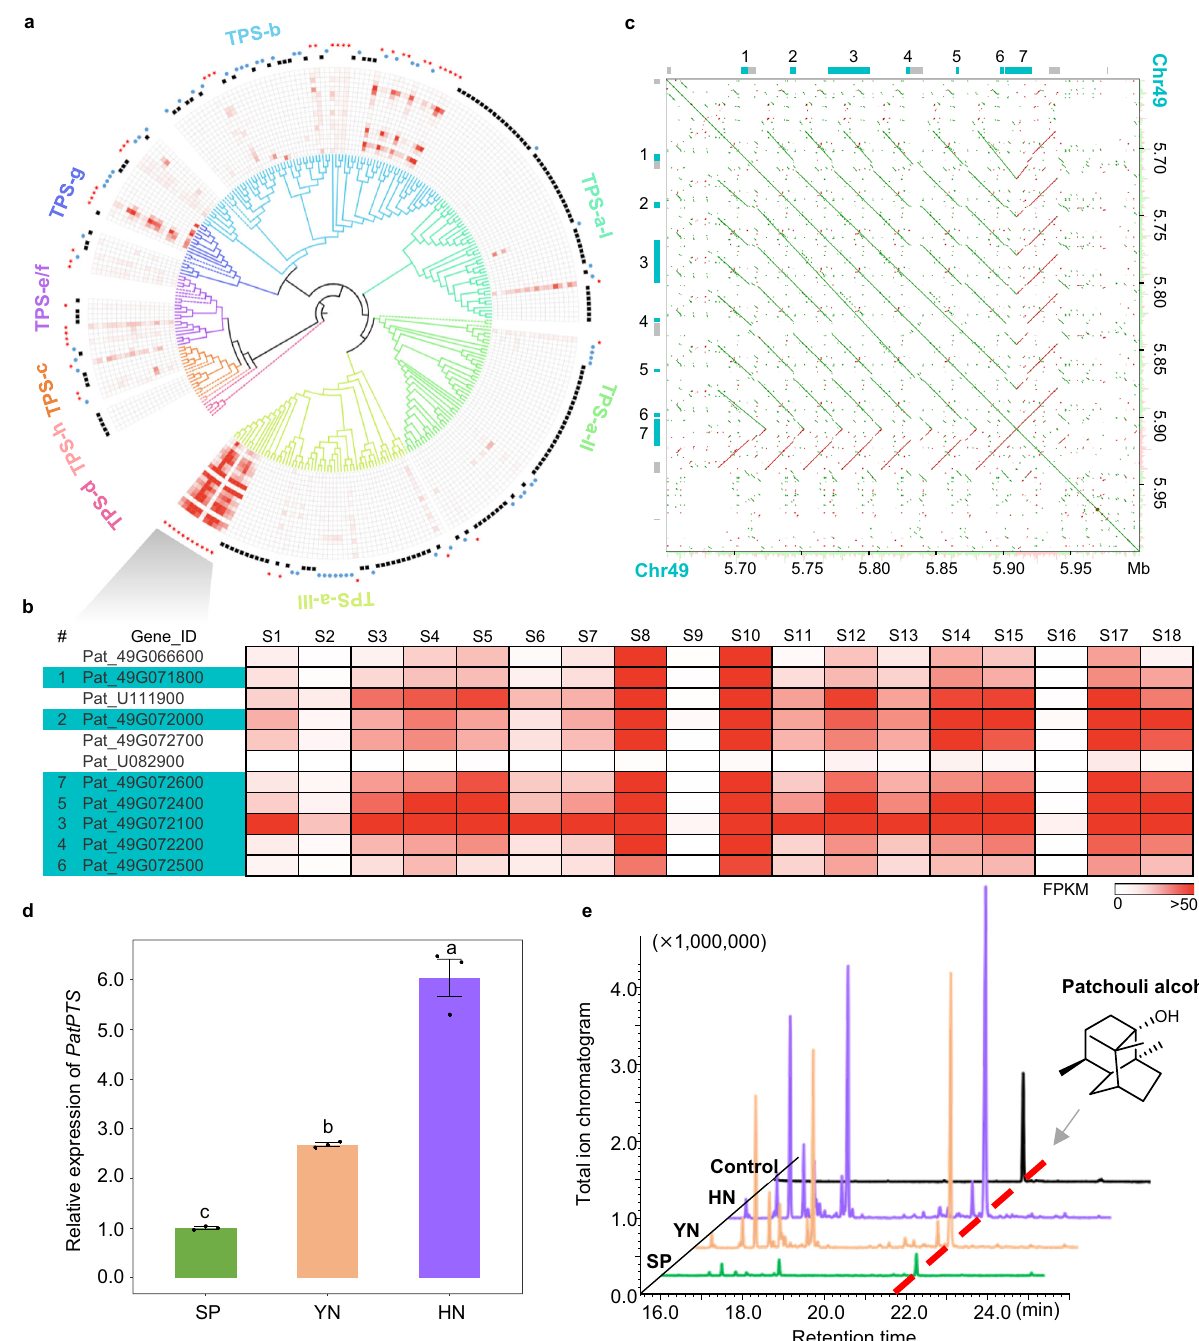
Fig. 2 Tandemly duplicated genes in the sesquiterpene biosynthetic pathway. a Phylogenetic tree and expression pattern of 266 TPS genes in the patchouli genome. Solid lines in the phylogenetic tree represent patchouli genes, dashed lines represent genes from other species with clear subfamily de fi nitions. The gene is denoted by a black square when its total FPKM is <1 in 18 RNA-seq datasets, by a blue square when its FPKM is >1 in 1 – 5 RNA-seq datasets and by a red star when its FPKM is >1 in >6 RNA-seq datasets. b Magni fi ed view for part of the PTS-a-III group with high expression. The seven tandemly duplicated PatPTS genes on Chr49 are highlighted by cyan. c Dot-plot analysis of sequences from 5.65 Mb to 6.00 Mb on Chr49. Boxes indicate gene locations, and cyan boxes indicate genes numbered in Fig. 2b. Green and red dots represent forward and reverse alignments, respectively. d Total relative expression level of seven PatPTS genes in mature leaves of the SP, YN, and HN accessions. The values of three replications are shown for each accession and presented as mean values ± SEM. The different letters above each accession indicate signi fi cant differences by One-way ANOVA. LSD test and Bonferroni ’ s adjustment were performed for multiple comparison. e Relative abundance of patchouli alcohol in mature leaves of the SP, YN, and HN accessions. Source data are provided as a Source Data fi